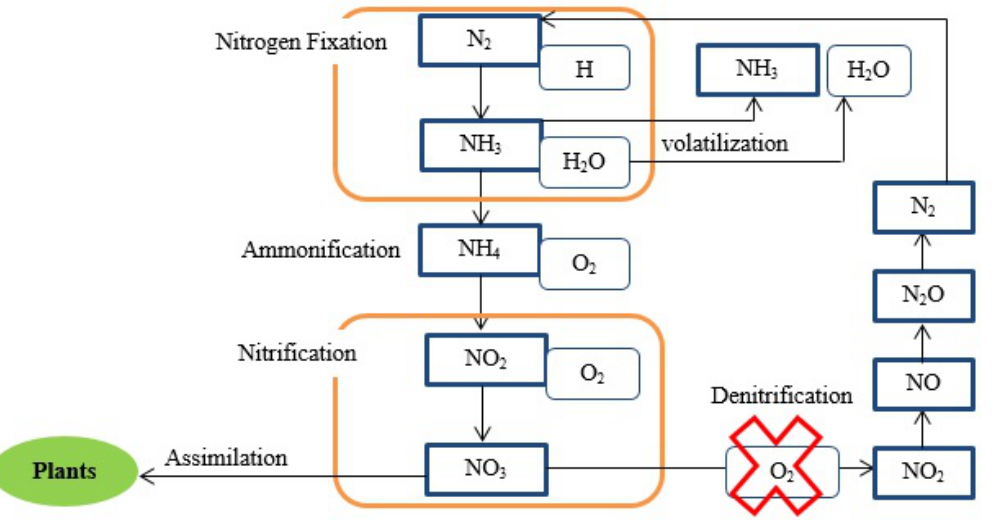
Fig. 2: The Nitrogen cycle occurs in the composting process